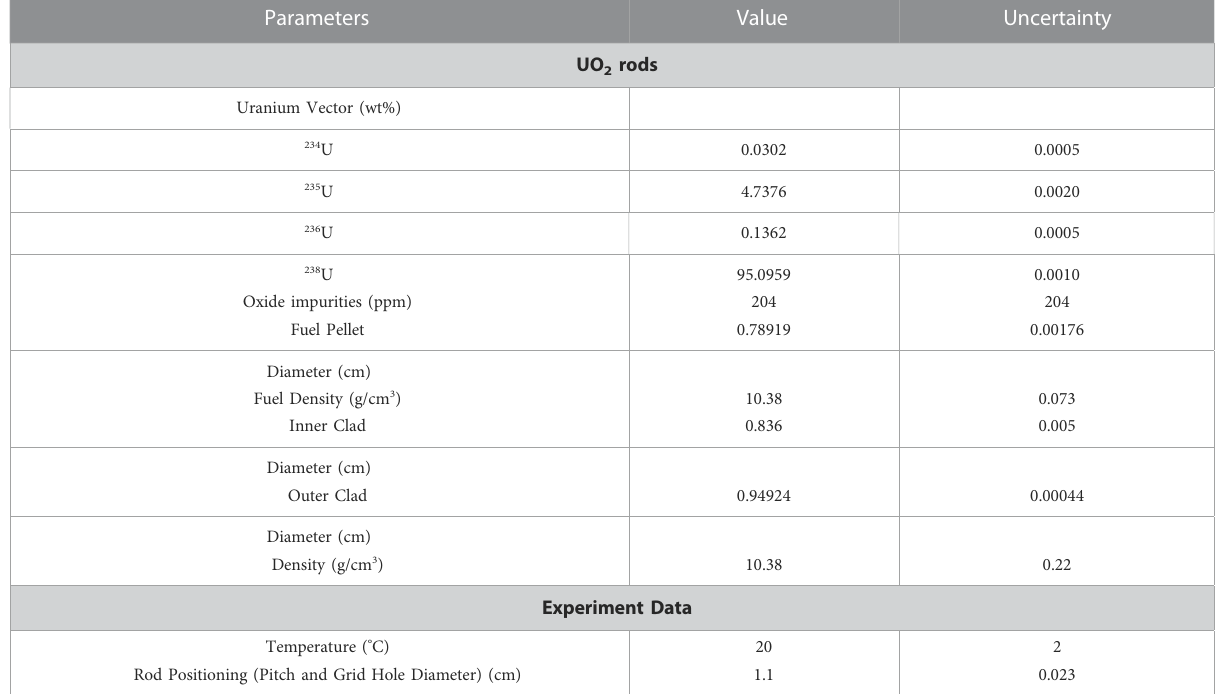
random uncertainties were ignored in revision 0 and are taken into account in revision 1. Moreover, the rod position being the source of large uncertainty, its treatment has been modi fi ed using Monte Carlo sampling in revision 1, contributing to a reduction of its propagated value. It can also be seen that for cases with a small pitch the rod positioning has a non-negligible effect on the overall uncertainty.